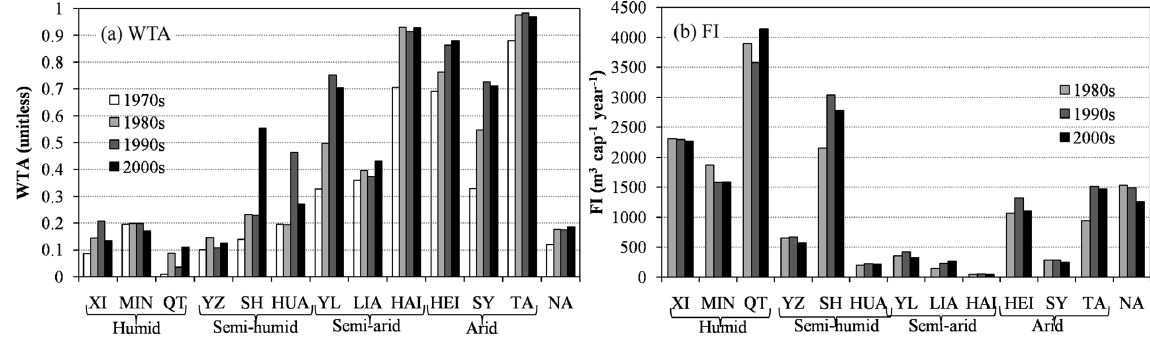
Figure 4. Changes of WTA and FI in 12 basins and China from the 1970s and 1980s to the 2000s. YZ, XI, MIN, QT, SH, HUA, YL, LIA, HAI, HEI, SY, TA, and NA represent Yangtze, Xi (Pearl), Min, Qiantang, Songhua, Huai, Yellow, Liao, Hai, Hei, Shiyang, Tarim River basins, and the national range, respectively.